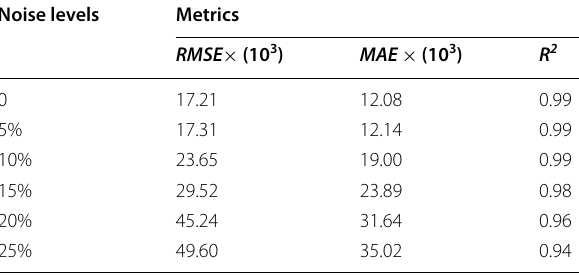
Table 3 Prediction performance of the normal digging resistance at different noise